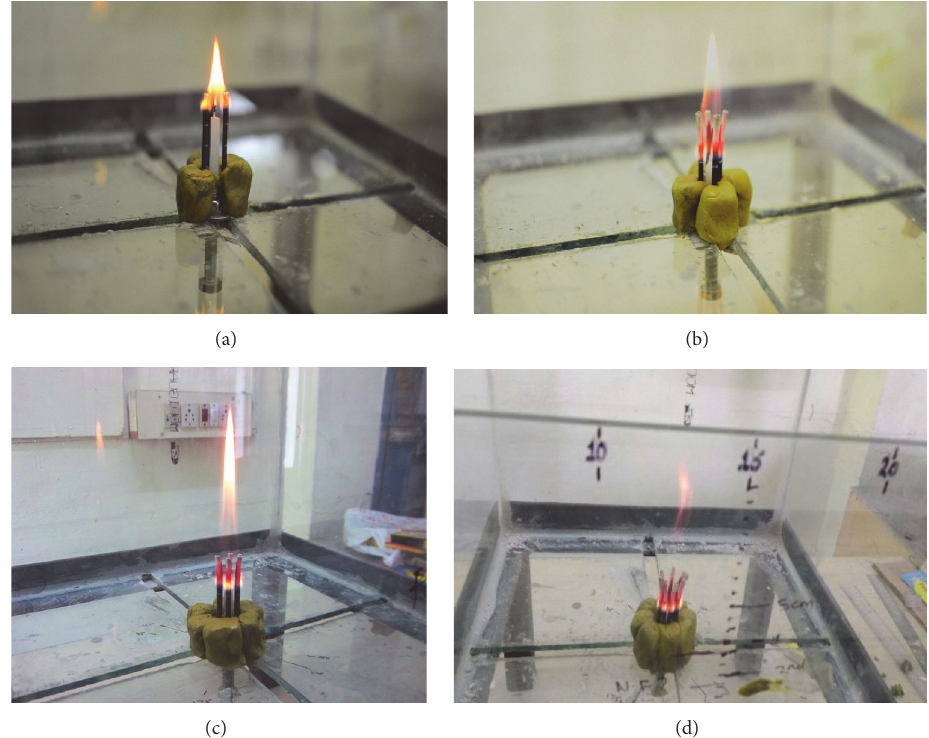
Figure 9: Pictorial view of transitional smoldering in nearby field (0.5 cm): (a) three, (b) four, (c) six, and (d) eight incense sticks, respectively.